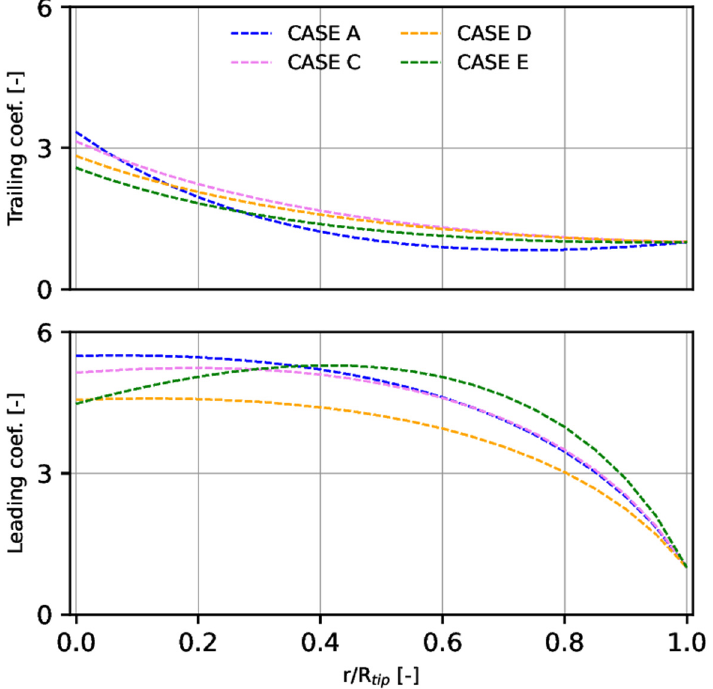
Figure 9. Distribution of the material FEC coefficient for the leading ( top ) and trailing ( bottom ) region of the cases: A, C, D and E.